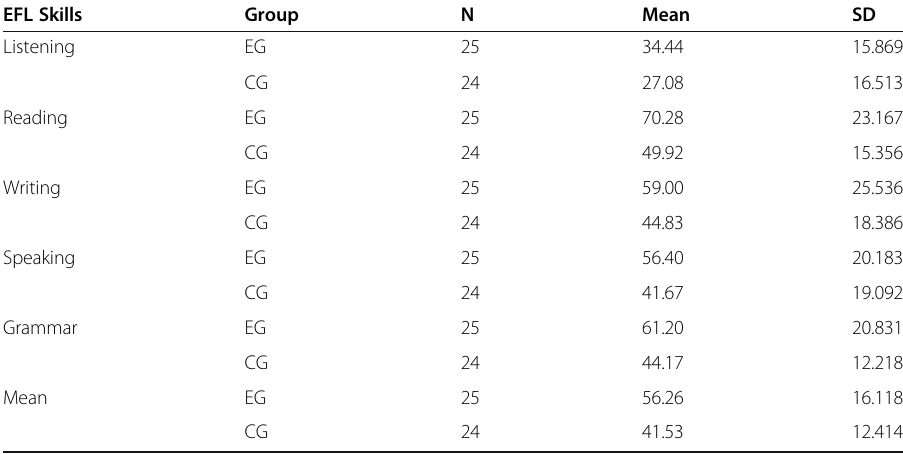
Table 3 Descriptive achievement post-test statistics